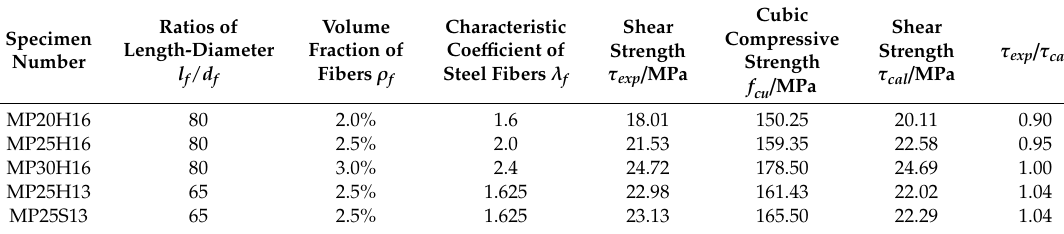
Table 7. Tests of UHPC shear